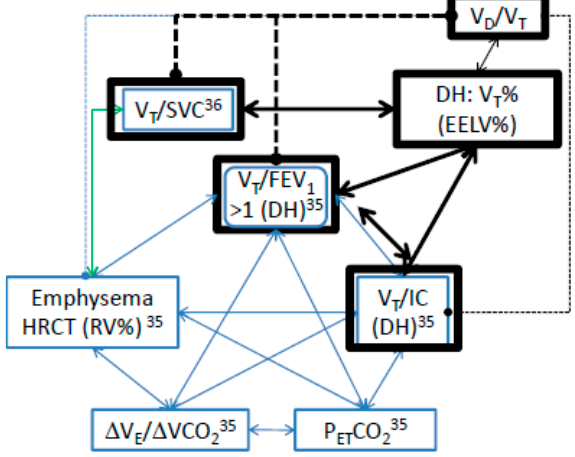
Figure 3. Relationships among dynamic hyperinflation (DH) variables and relationships between DH variables and dead space fraction (V D / V T ) in patients with chronic obstructive pulmonary disease. Black bolded boxes, from this study; blue boxes, from References [35,36]. Solid lines, significantly correlated; dashed lines, not significantly correlated. Black lines, from this study; blue lines, from reference [35]; green line, from reference [36]. V T %, tidal volume and total lung capacity (TLC) ratio; EELV%, end-expiratory lung volume and TLC ratio; V T / SVC, V T and slow vital capacity ratio; V T / FEV 1 , V T and forced expired volume in one second ratio; HRCT, high resolution computed tomography; RV%, residual volume predicted %; ∆ V E / ∆ VCO 2 , slope of minute ventilation and CO 2 output; P ET CO 2 , end-tidal CO 2 pressure.